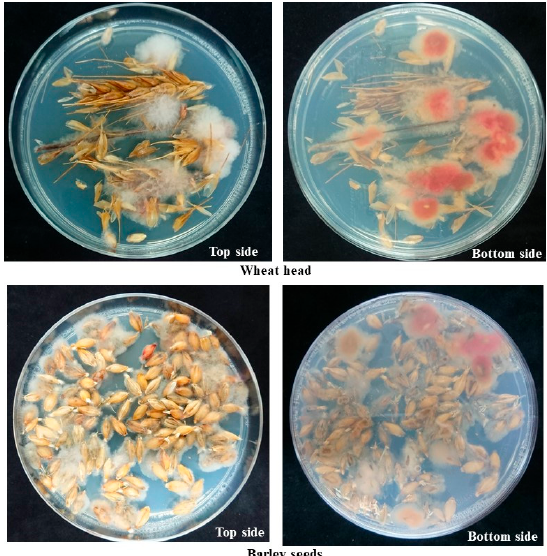
Figure 5. Isolation of species in the Fusarium graminearum species complex from wheat head or barley seeds on the FG21 medium. Wheat head or barley seeds were placed on FG21 medium after surface sterilization and kept at 25 °C for 3 days. Reddish colonies were identified as nivalenol type of Fusarium asiaticum using a dipstick DNA chromatography assay.